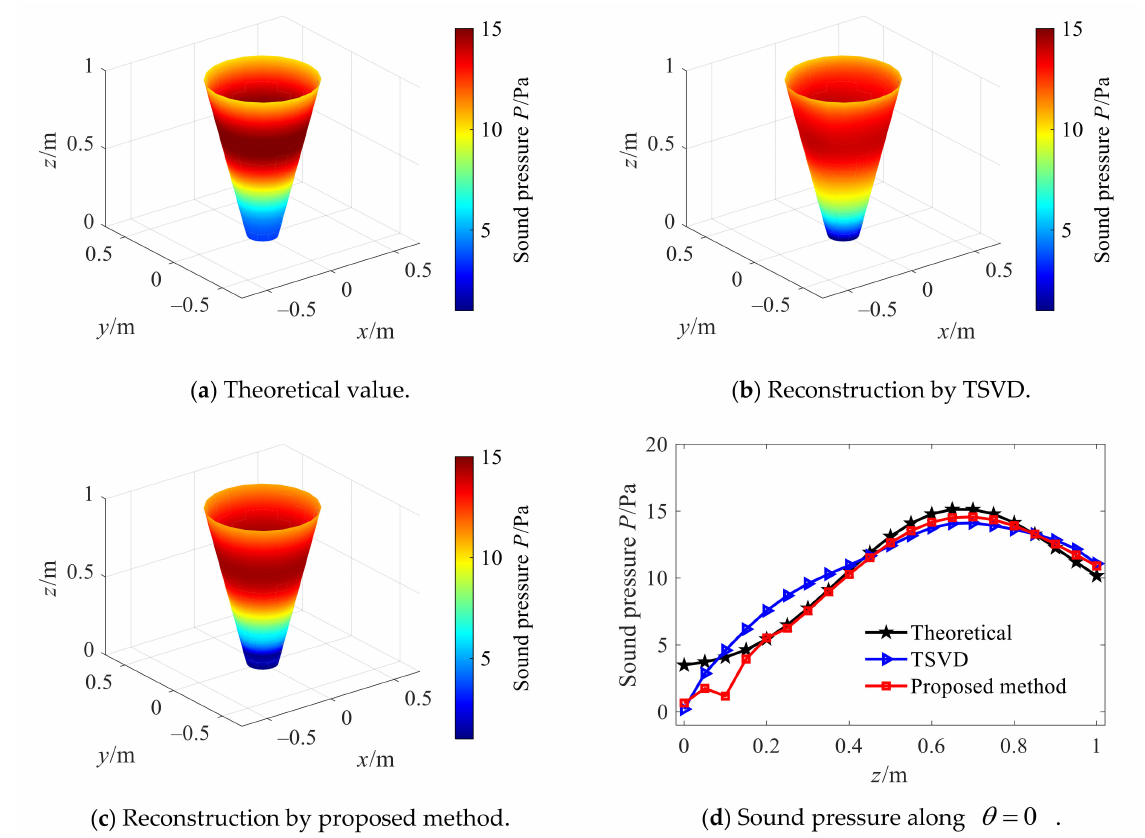
Figure 18. Reconstruction by TSVD and proposed method.